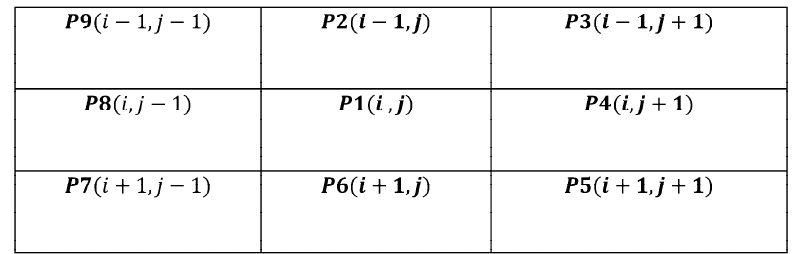
Figure 4. Counting the 01 patterns in the ordered set P2,…, P9 . Algorithm 1: FPT 1: A (P1) is the number of (01) patterns in the ordered set